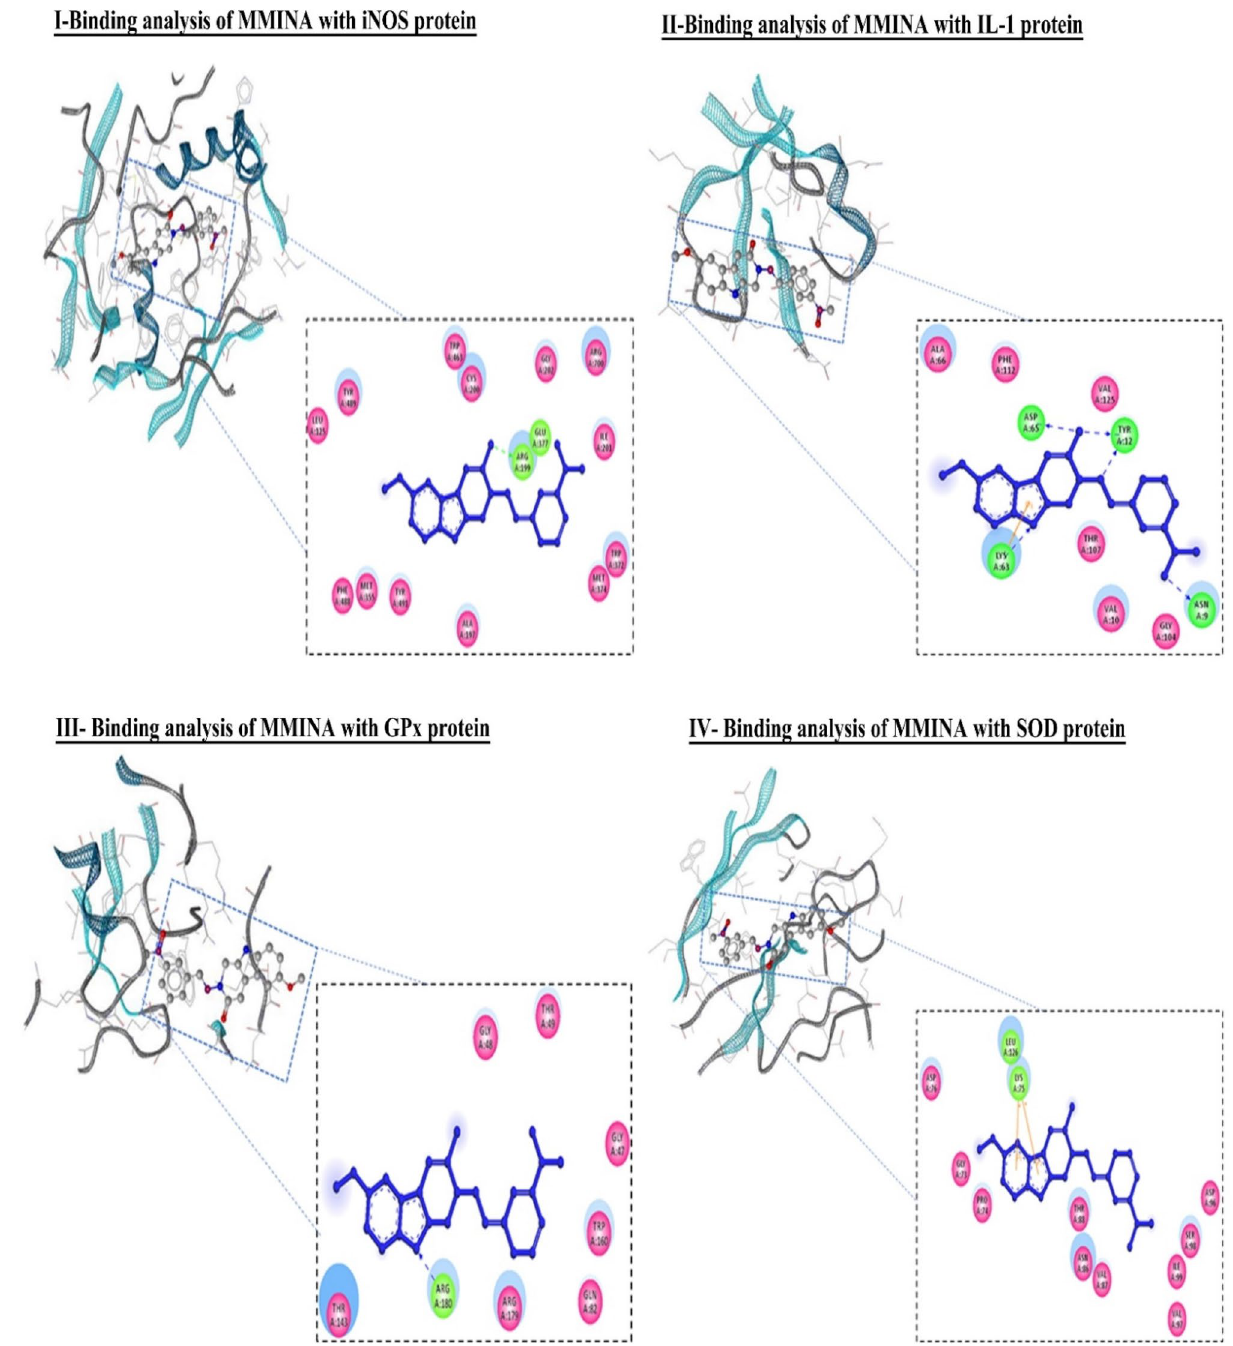
model represent the MMINA in 2D conformation, residues involved in hydrophobic interactions are shown in pink disc (hydrophobic interactions in GPx, while the residues involved in covalent and coordinate covalent interactions are shown in green disc (covalent in GPx, H-bond in IL-1). Orange colour line in IL-1 was indicating pi